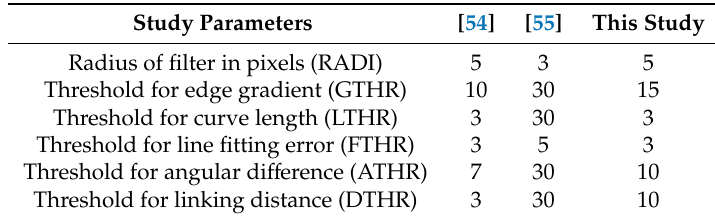
Table A1. Lists of parameter values of automatic lineament extraction, and literature. Study Parameters [54] This